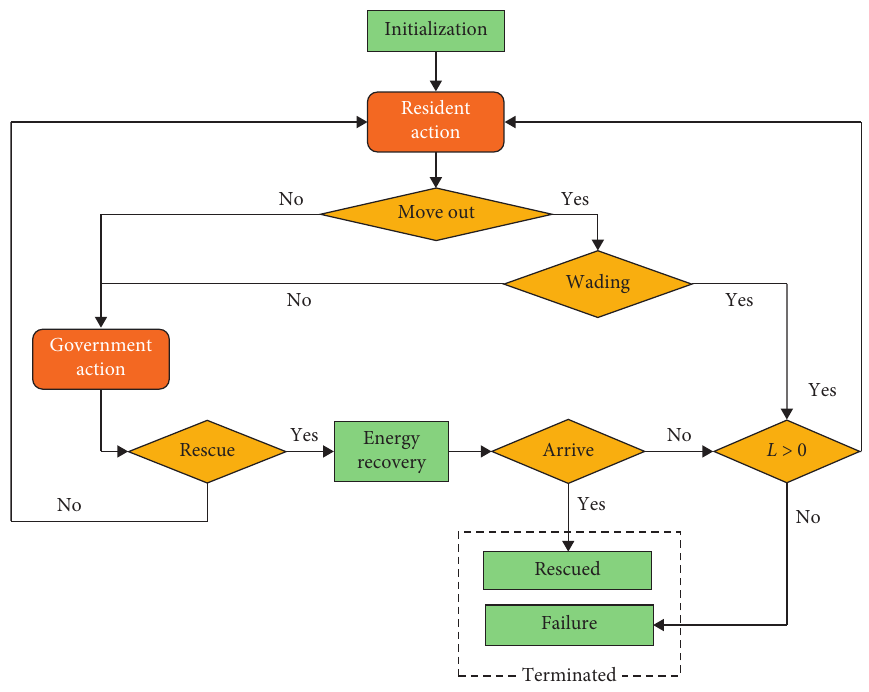
Figure 1: Common disaster relief